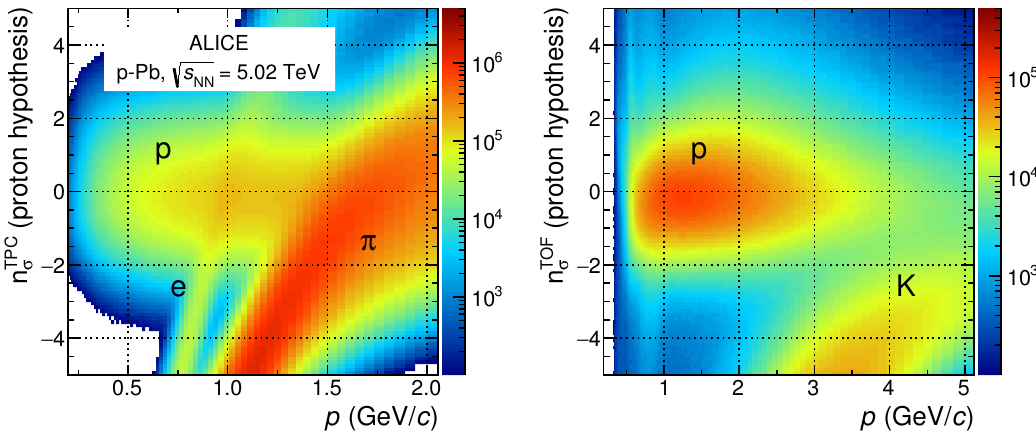
Figure 1 . Proton identi(cid:12)cation with TPC (left) and TOF (right) in p-Pb collisions. The discrim- inating PID variable n (cid:27) (see text for details) is shown as a function of the momentum p of the particle. The n (cid:27) variable is computed assuming the proton hypothesis. The contributions from electrons and pions in the TPC and from kaons in the TOF are